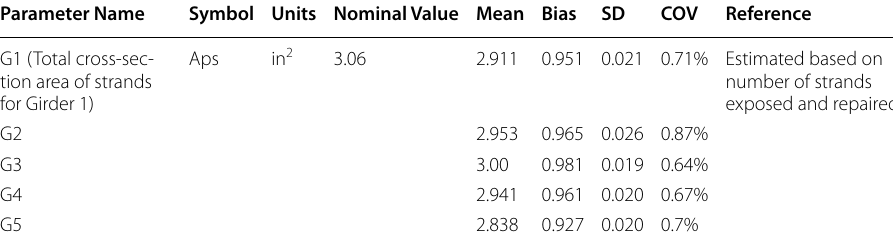
Table 2 Mean and standard deviation values of remaining strands cross section after the repairs Parameter Name